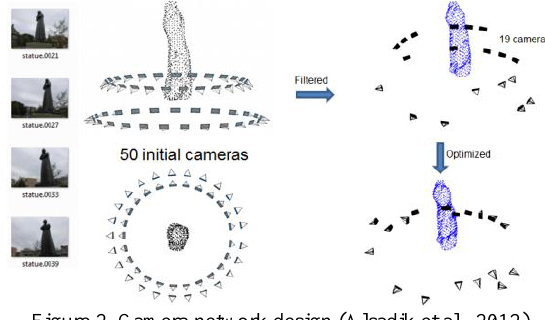
Figure 2. Camera network design (Alsadik et al.,